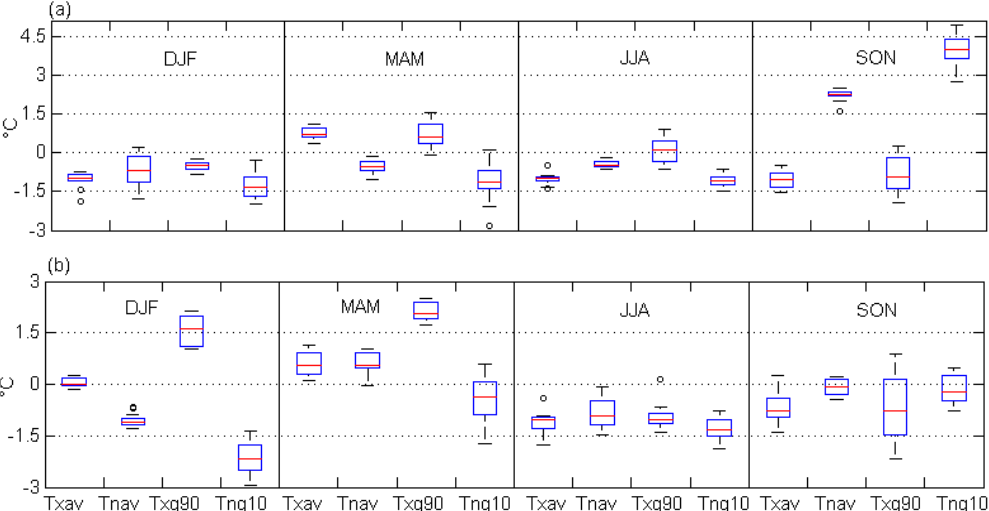
Fig. 3. Biases of the extreme temperature indices downscaled from the CGCM3 (a) and the ECHAM5 predictors (b) for the four seasons during the control period 1961-1990. The whisker-box plots depict the range of the bias across 13 stations. The boxes denote the median and interquartile range (IQR). Whiskers extend 1.5 IQR from box ends, with outliers denoted as circles.